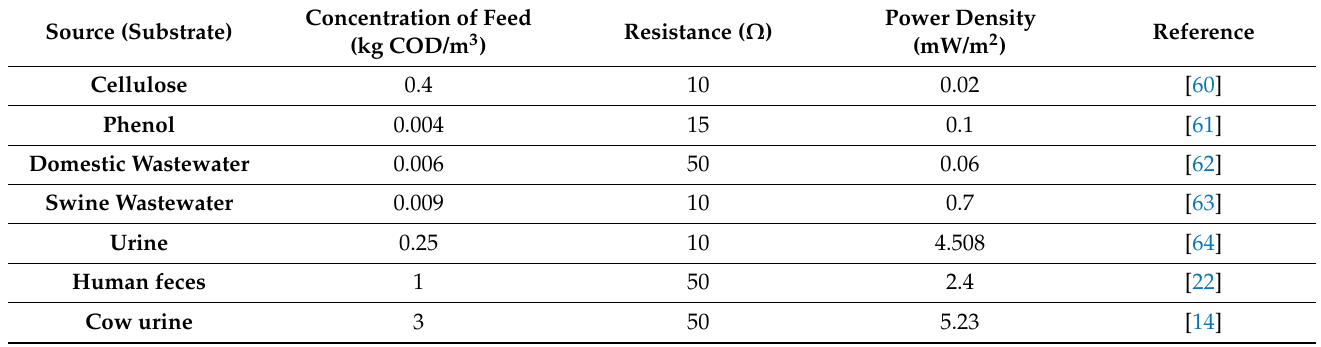
Table 2. Power density of a microbial fuel cell with varied substrates, substrate concentrations and